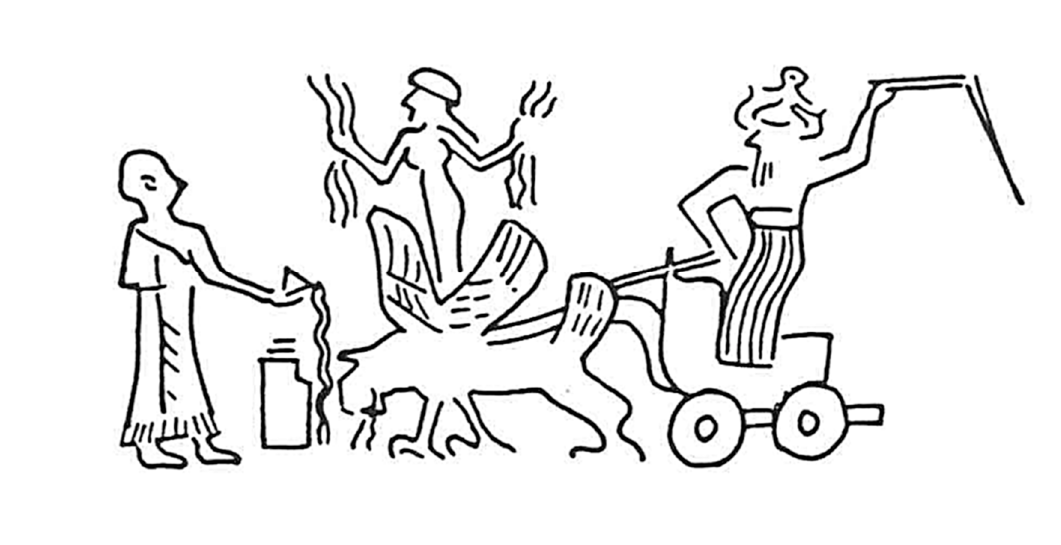
Figure 4. Naked goddess with lightning bundles on a lion dragon harnessed to the storm god’s chariot (Leinwand 1992: Figure 13).